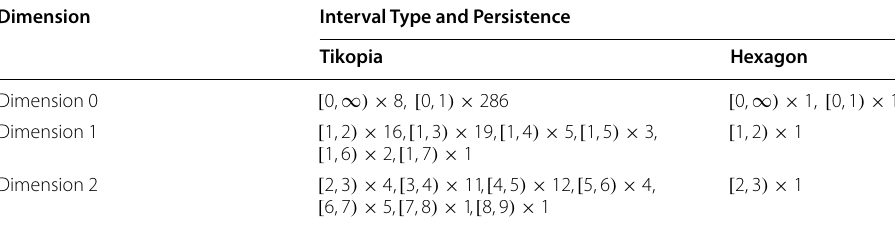
Table 1 The persistence intervals of the Tikopia genealogical network and the hexagon network are